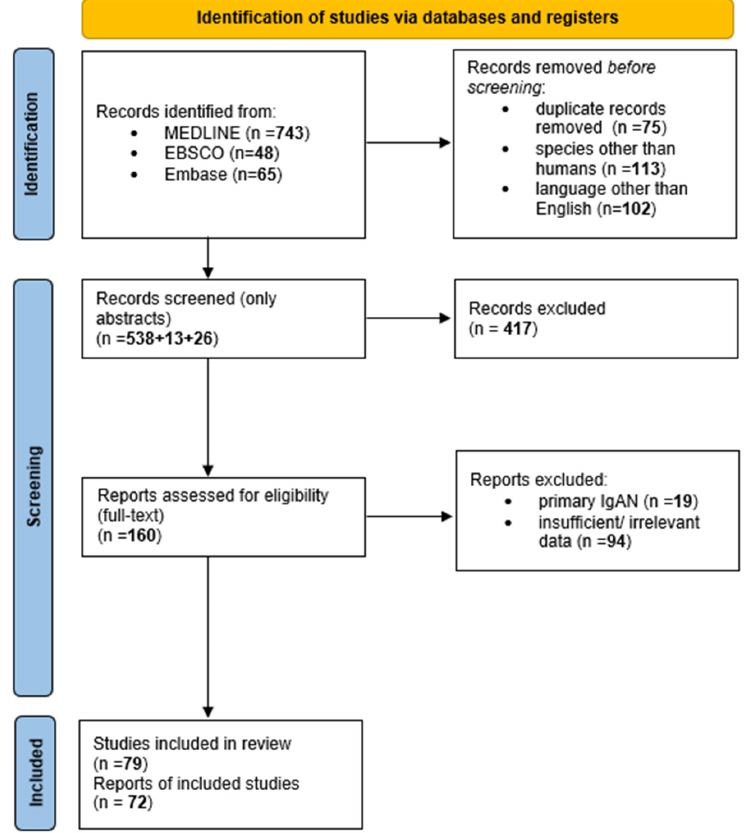
Figure 1. A fl ow diagram based on PRISMA guidelines [17]. Figure 1. A flow diagram based on PRISMA guidelines